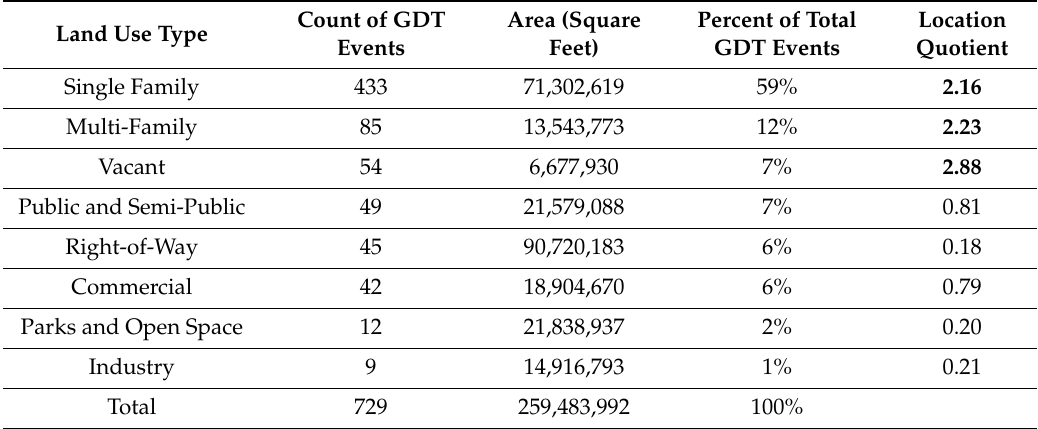
Table 1. Sum and distribution of GDT events by land use type including location quotients.